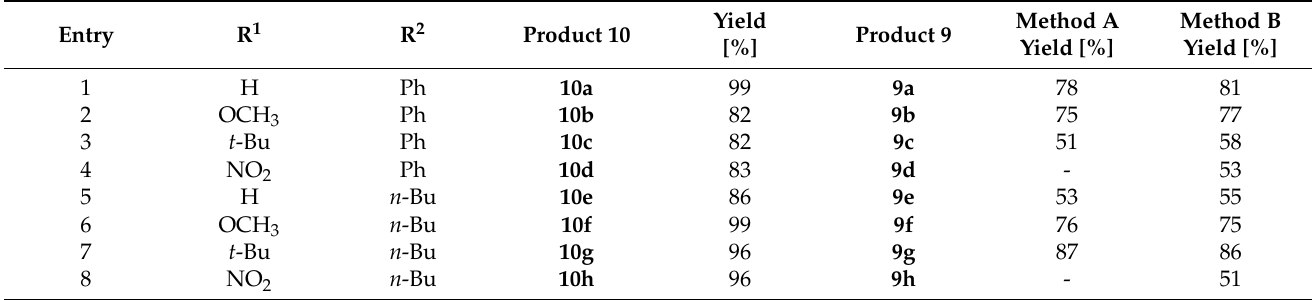
Table 2. The yield of the reaction for the preparation of precursors containing a 4 H -1,2,4-triazole ring ( 9a – h ).